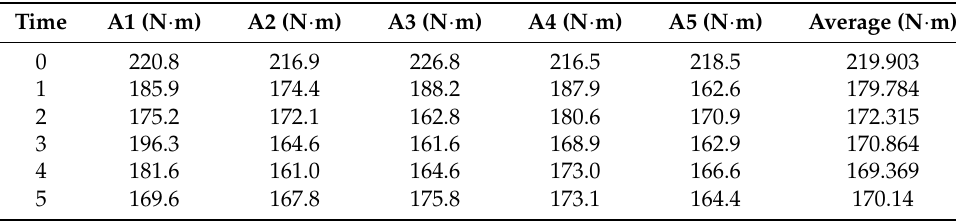
Table 5. Static torque of permanent magnet brake under different baking times.